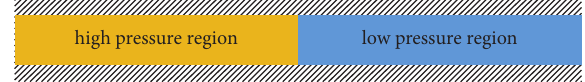
Figure 4: A typical shock tube problem.